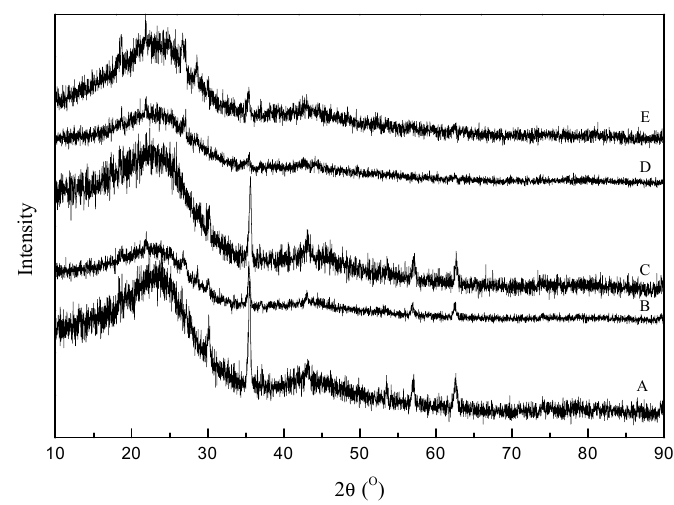
Figure 3. XRD spectra of bamboo-derived carbonaceous magnetic solid acid prepared with different